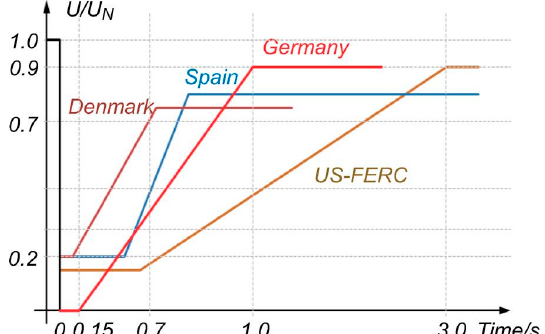
Figure 8. Different fault ride through (FRT) curves of a defined stay ‐ connected time for the inverter interfaced DG (IIDG).